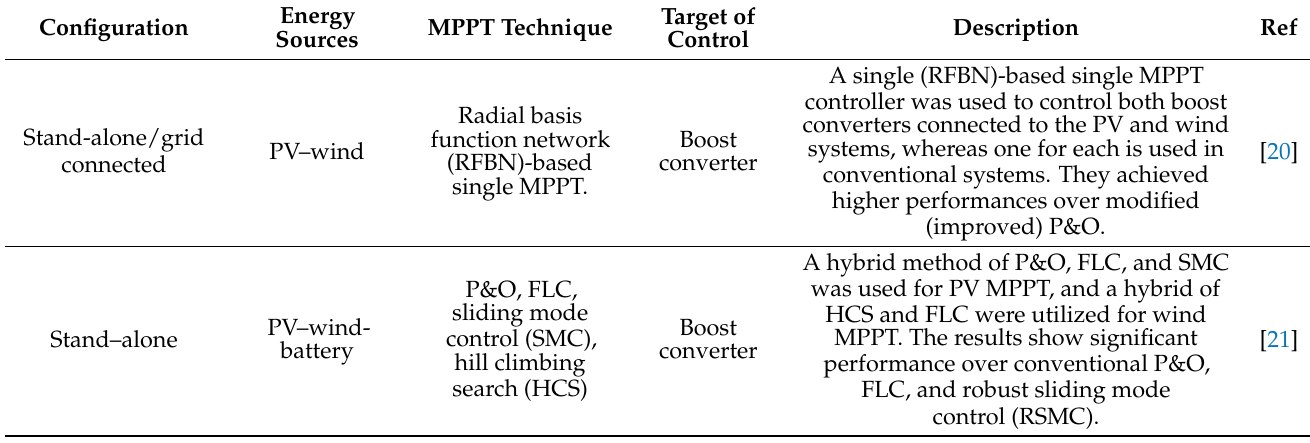
Table 1. A review of recent maximum power point tracking (MPPT) techniques for PV and wind renewable energy systems.